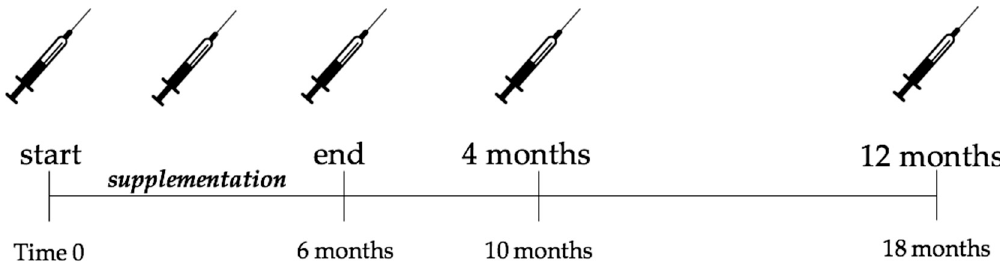
Figure 1. Study time line. Syringes indicate blood sampling. The results of the supplementation protocol have been presented elsewhere [10,11].